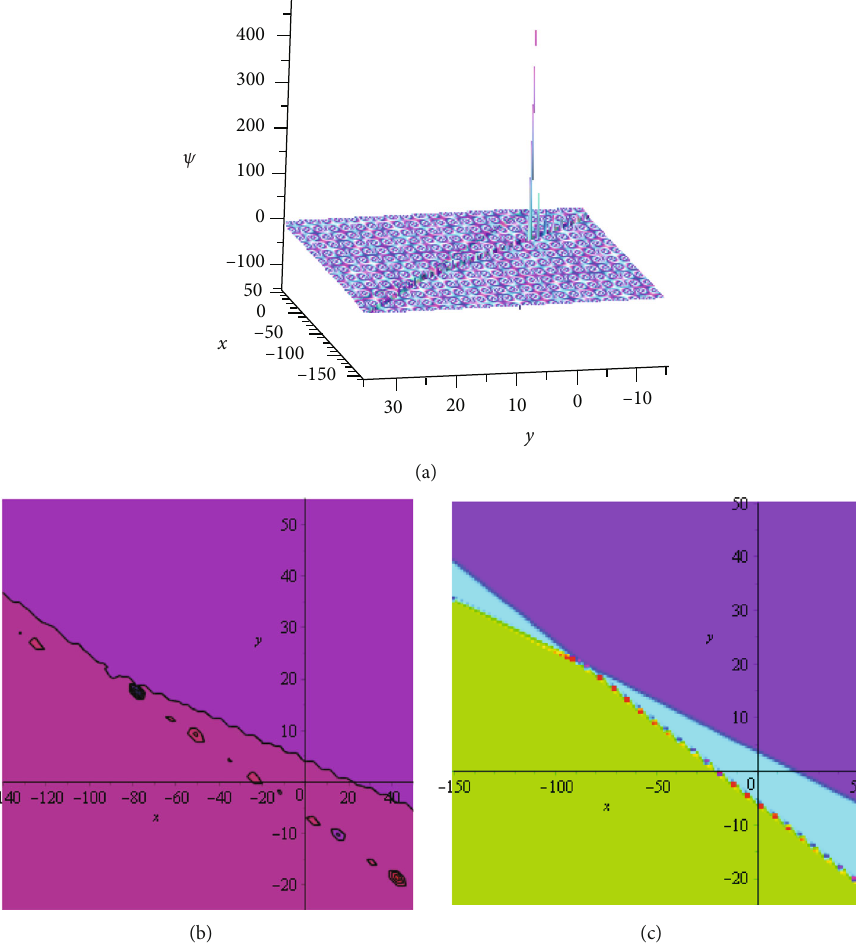
= : 2, Ω = 2, δ = 1, δ = 1 : 3 6 7 1 2